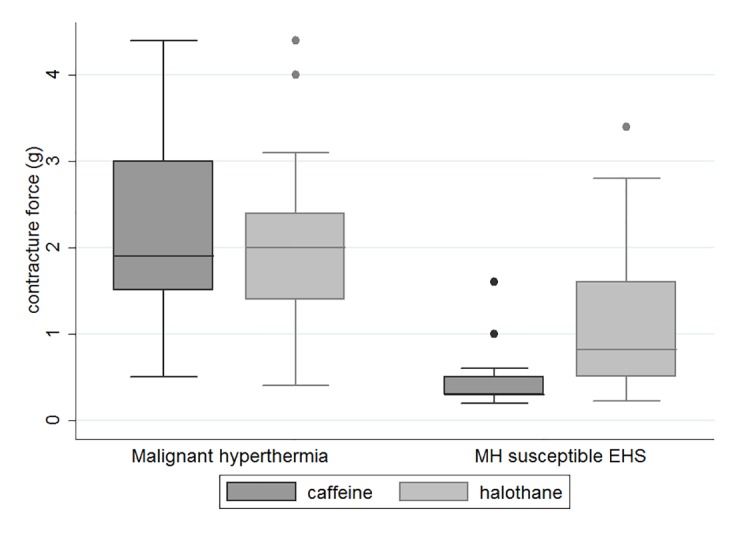

In vitro contracture test response for malignant hyperthermia and malignant hyperthermia-susceptible EHS patients.
In vitro muscle bundle contracture force (g) for halothane and caffeine among malignant hyperthermia patients (left) and among IVCT-diagnosed malignant hyperthermia-susceptible patients with a history of exertional heat stroke (right) (p<0.0001 for halothane and caffeine). Abbreviations: IVCT, in vitro contracture test; EHS, exertional heat stroke.